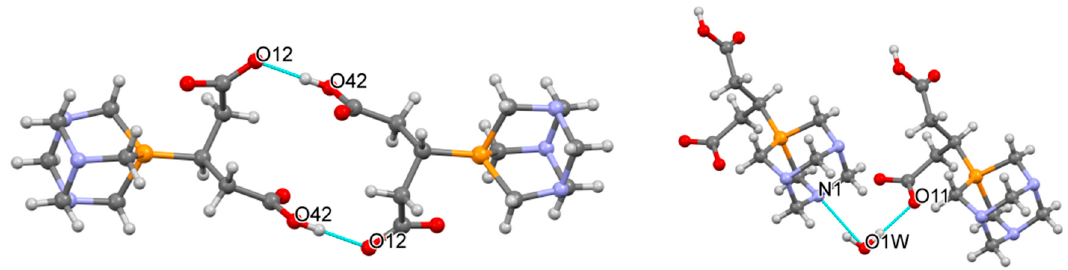
Figure 5. Typical view of 1 in its crystal structure. ( Left ): H-bonds between PTA units, ( Right ): H-bonds between PTA and H 2 O molecules. (O42–H...O12 (ii) = 2.571(3) Å, O1W–H...O11 = 2.781(3) Å, O1W–H...N1 (i) = 2.889(3) Å [Symmetry codes: (i) x,y, − 1 + z, (ii) 1 − x, − y,z]).